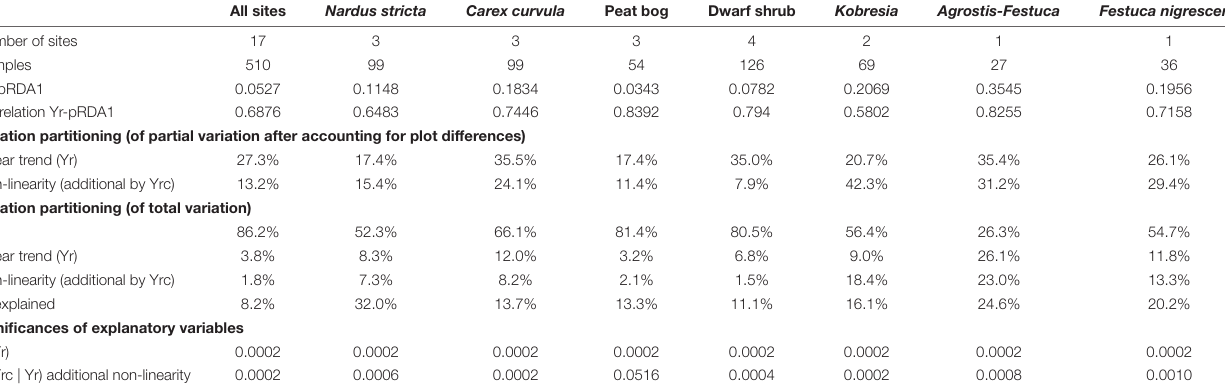
TABLE 2 | Results of the pRDA (of all diversity parameters, total frequency, C-S-R strategies, and Landolt indicator values): changes over time for all grazed sites and grazed communities separately. All sites